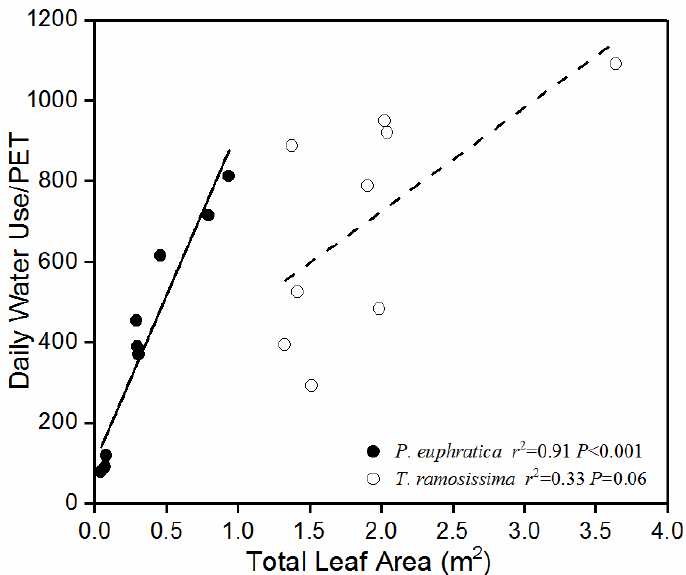
Figure 3. Relationships between PET (mm d -1 ) normalized daily water use (g d -1 ) and whole-plant leaf area in Populus euphratica and Tamarix ramosissima grown at a groundwater level gradient.